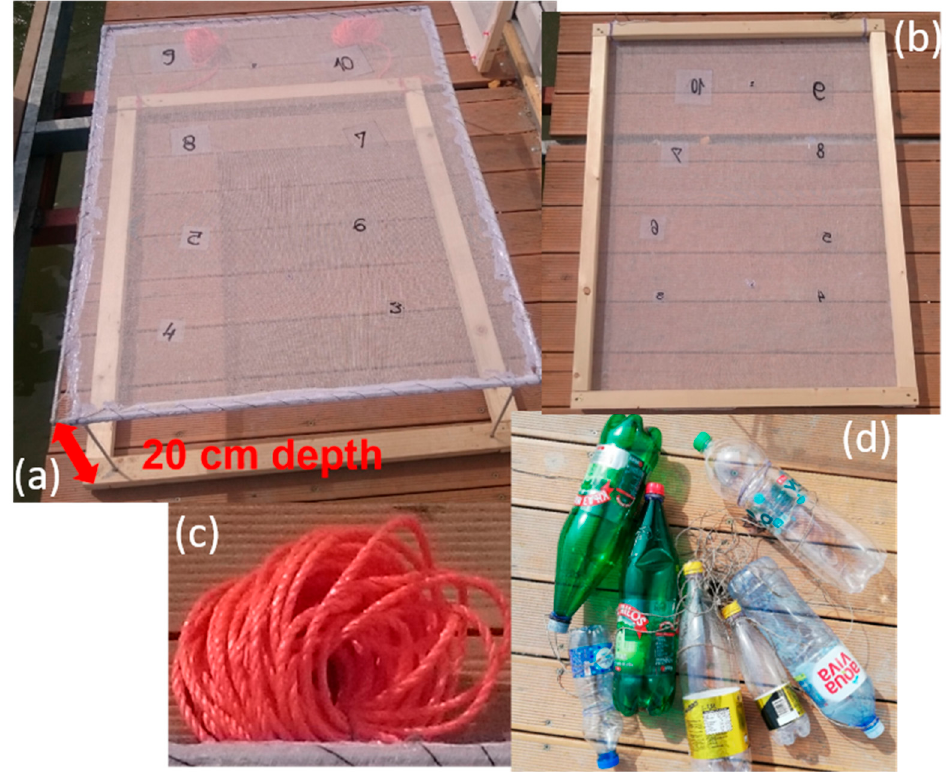
Figure 2. Targets used in the study area located in Lake Balkana ( a ) frame with metal construction for